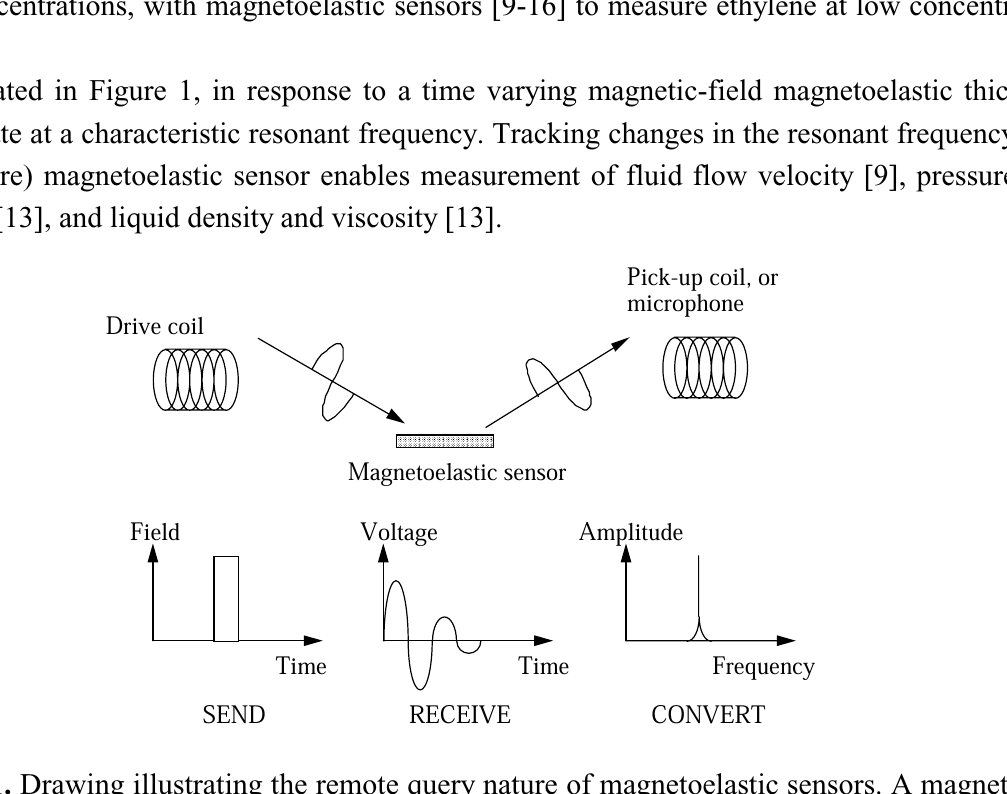
Figure 1. Drawing illustrating the remote query nature of magnetoelastic sensors. A magnetic field impulse is applied to the sensor; the transient response is captured using either a pickup coil to detect the magnetic flux or a microphone to detect the mechanical vibrations, and then converted into the frequency domain using a fast Fourier transform. The resonant frequency is tracked to provide chemical and environmental